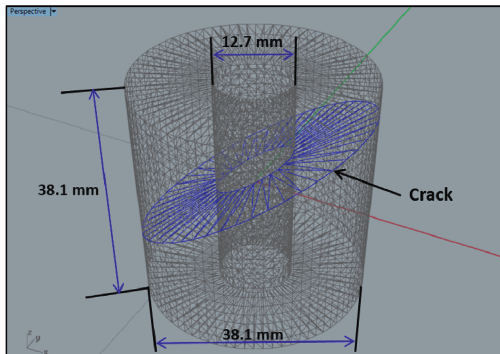
Figure 6: Dimensions of the TWC test sample containing an initial crack (highlighted in blue).